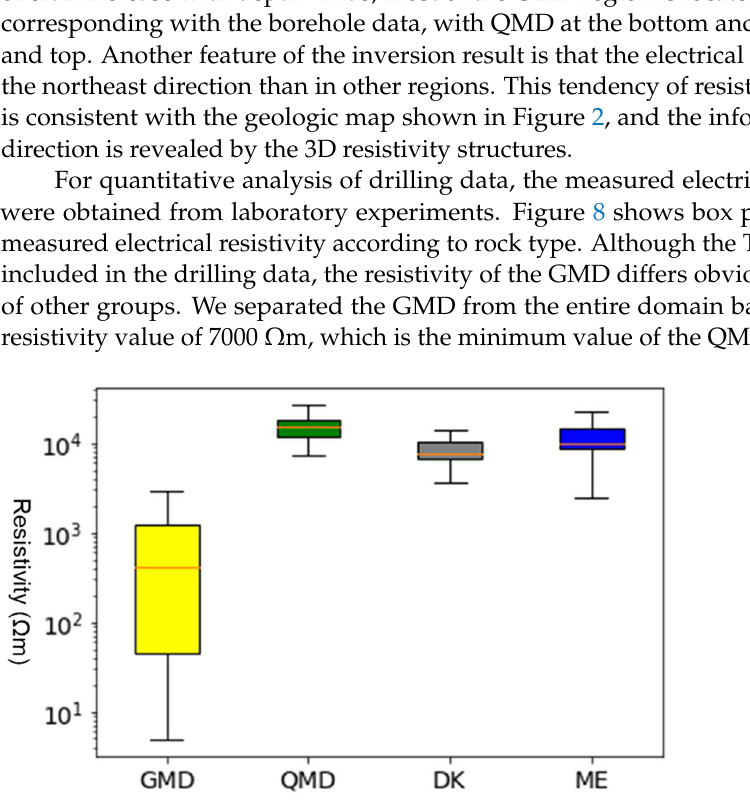
Figure 7. ( a ) Lithology of two drilling cores by depth, ( b ) location of drilling cores in exploration area.